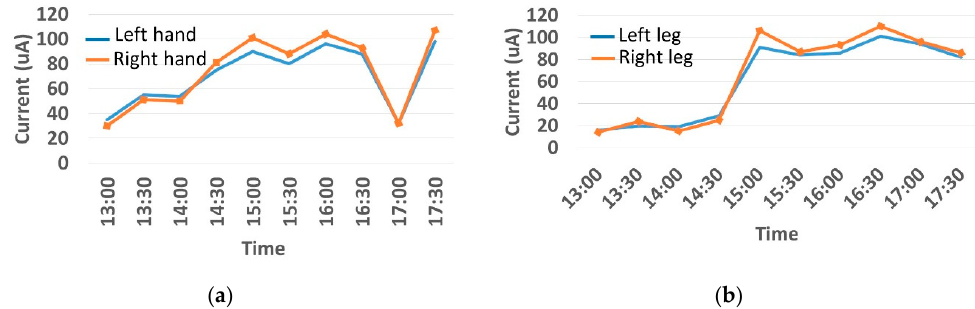
Figure 7. ( a ) The correlation between the Taiyuan acupoints (left hand vs. right hand). ( b ) The correlation between Taichong acupoints (left leg vs. right leg).